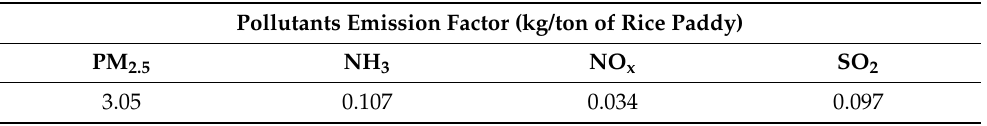
Table A1. Particulate Matter Formation Potential (PMFP) of Rice Straw Open Burning in